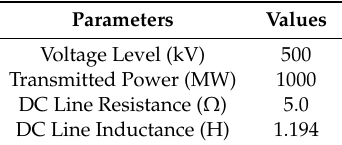
Table A1. DC side parameters of dual-infeed HVDC system.